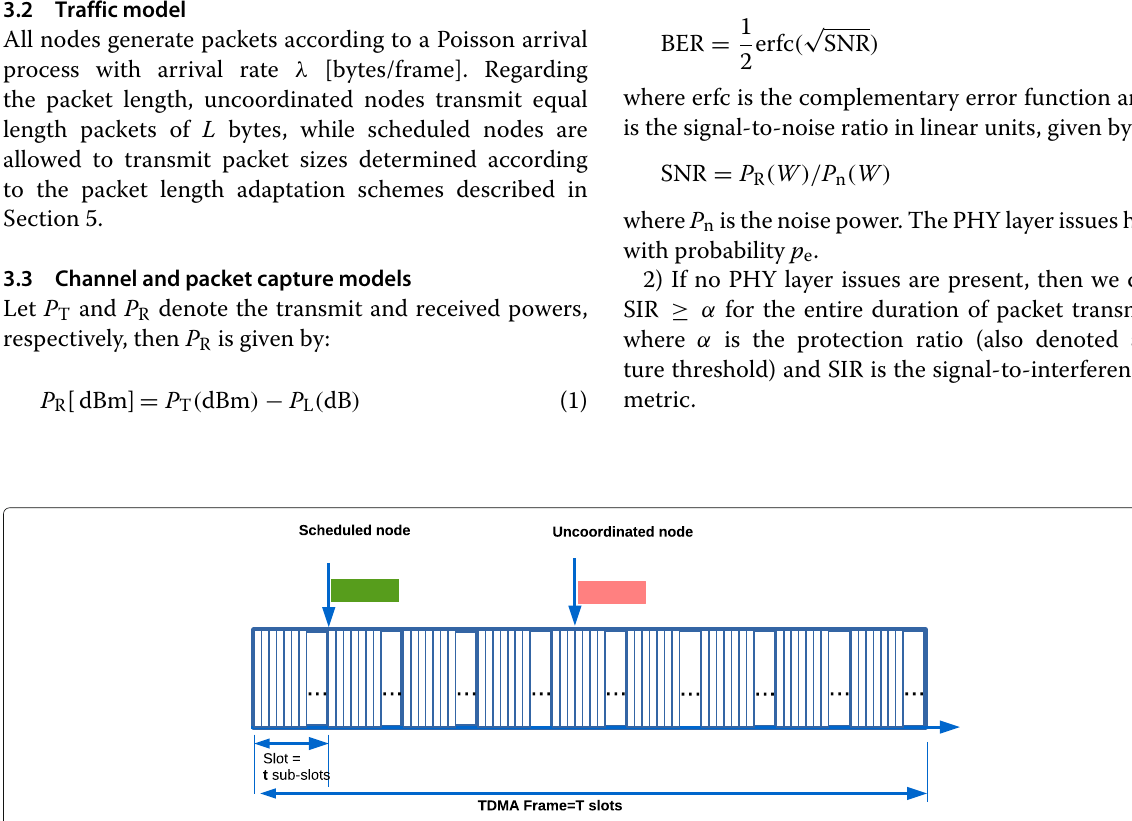
Fig. 3 Frame structure and packet transmission initial